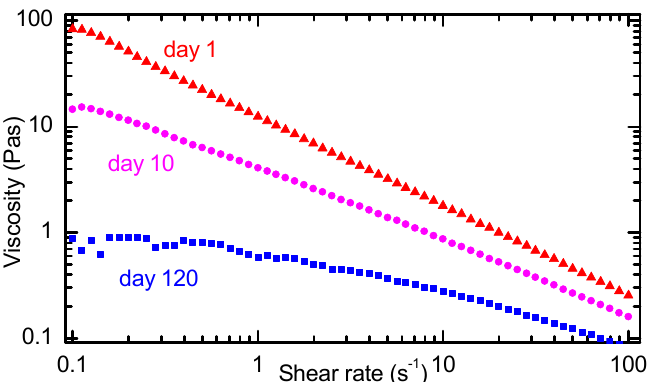
Figure 3. Steady shear viscosity profile of non-sonicated CNC suspensions stored for 1 day (red triangles), 10 days (magenta circles), and 120 days (blue squares).